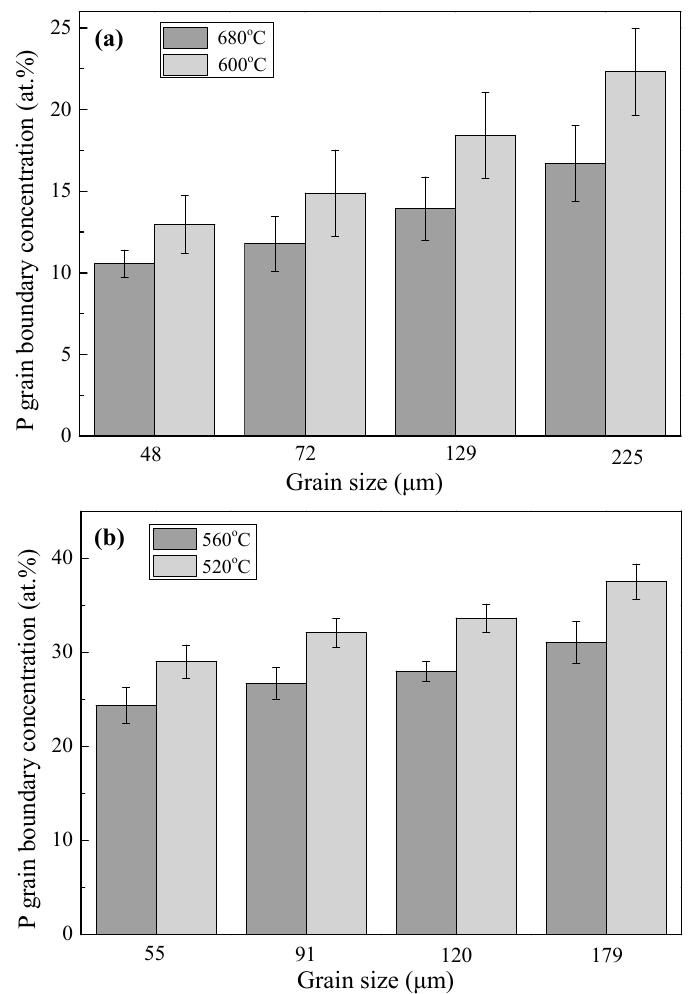
Figure 4. Segregation concentrations of phosphorus in: ( a ) IF; and ( b ) 2.25Cr1-Mo steels with different grain sizes (error bars represent the 95% confidence interval).